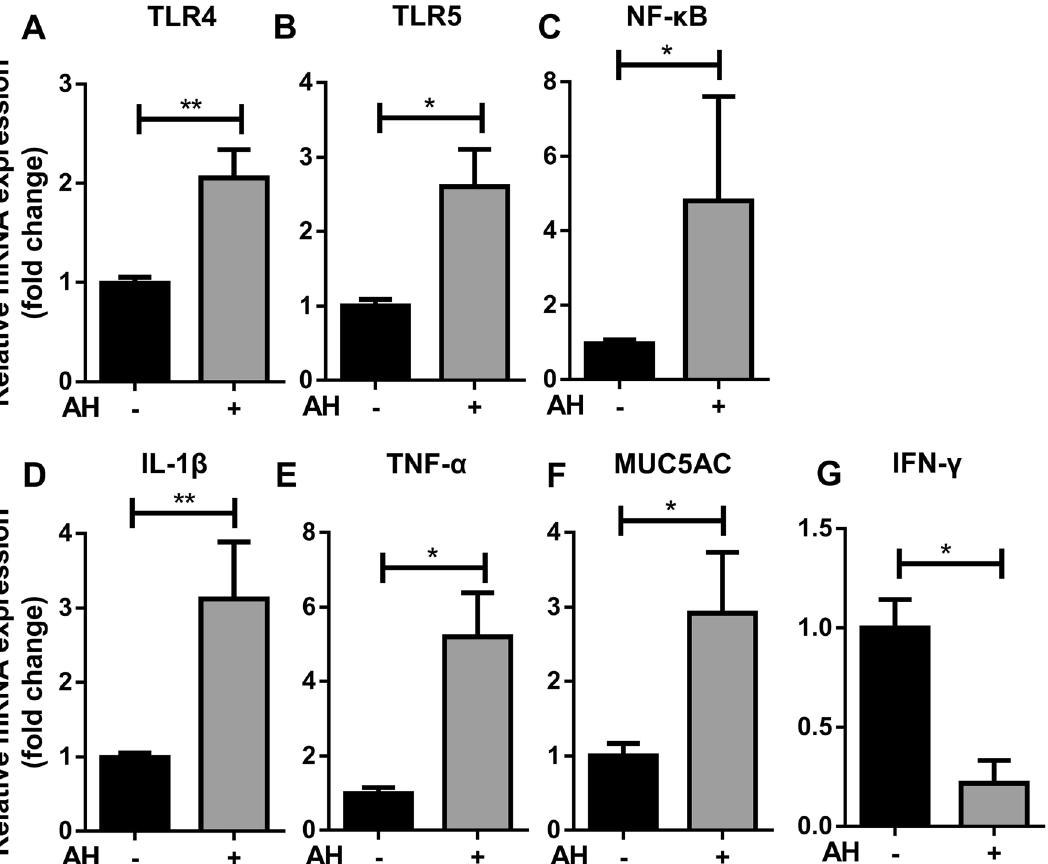
Figure 7. Effect of AH inoculation on innate immune marker expression in the skin model. The ventral skin model was inoculated with AH and incubated for 6 h. The RNA was extracted and followed by RT-qPCR for measuring expression. The expression of ( A ) TLR4, ( B ) TLR5, ( C ) NF-κB, ( D ) IL-1β, ( E ) TNF-α, ( F ) MUC5AC ( G ) IFN-γ in AH inoculated skin model were compared to expression in the no bacteria control assigned a value of 1. All data were shown as mean values (± SEM). Four fish and two replicates of tissue were used. Statistical significance was determined by using Student’s t-test. ***p ≤ 0.001; **p ≤ 0.01; *p ≤